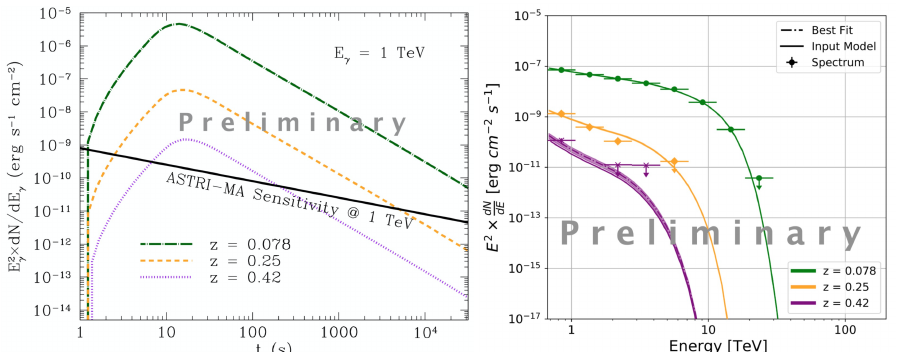
Figure 11. Left : lightcurve of GRB 190114C at 1TeV (dotted purple curve) also moved to redshift z = 0.25 (dashed yellow) and z = 0.078 (dot-dashed green). The sensitivity of the ASTRI Mini- Array at 1TeV is shown with a black solid line. Right : simulation of the spectrum of GRB 190114C integrated between 200 and 800 s as detected by the ASTRI Mini-Array (purple). Simulations of the same spectrum moved at closer redshift are also shown. From